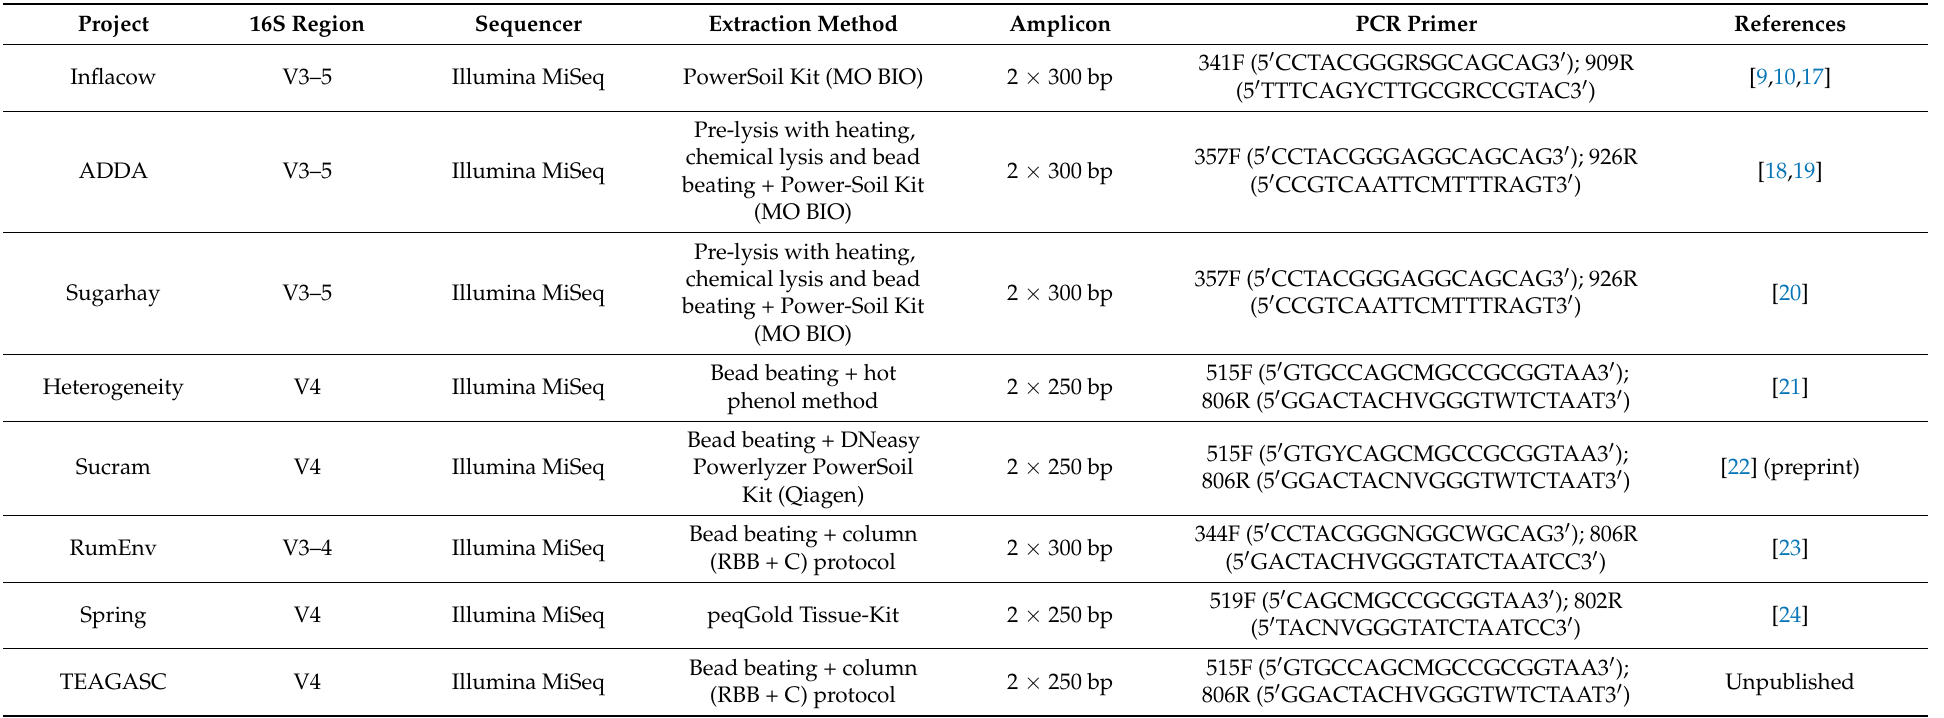
Table 2. Detailed experimental characteristics of the studies included in the